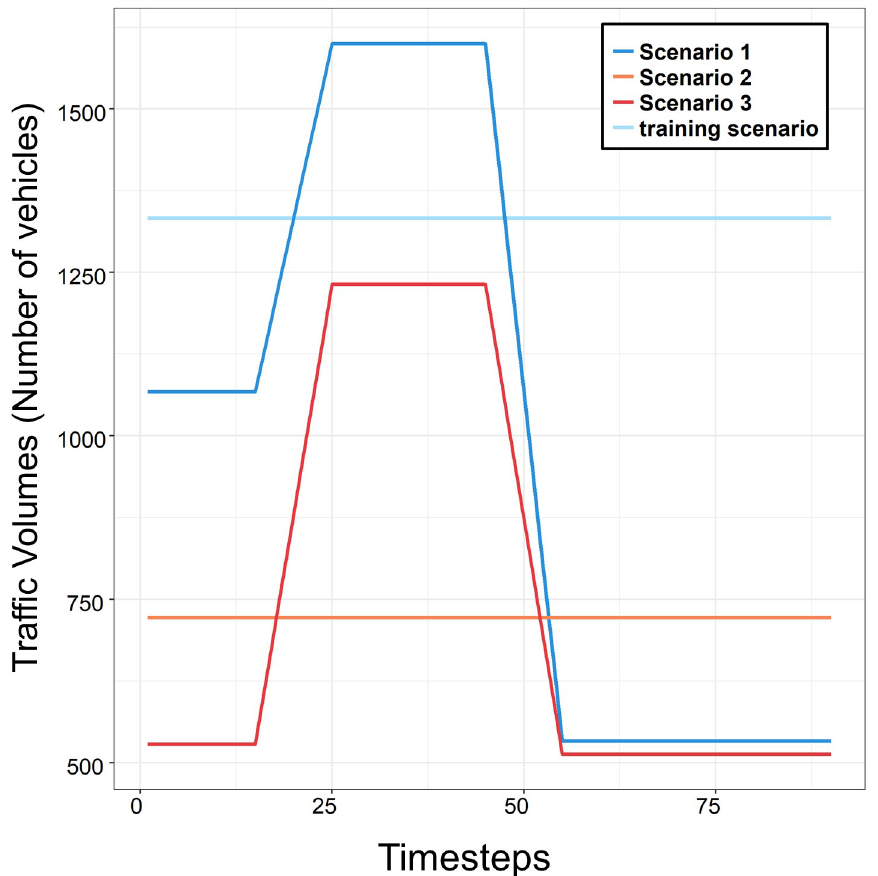
Fig 3. Traffic volumes of the test demand scenarios. (Drawn by